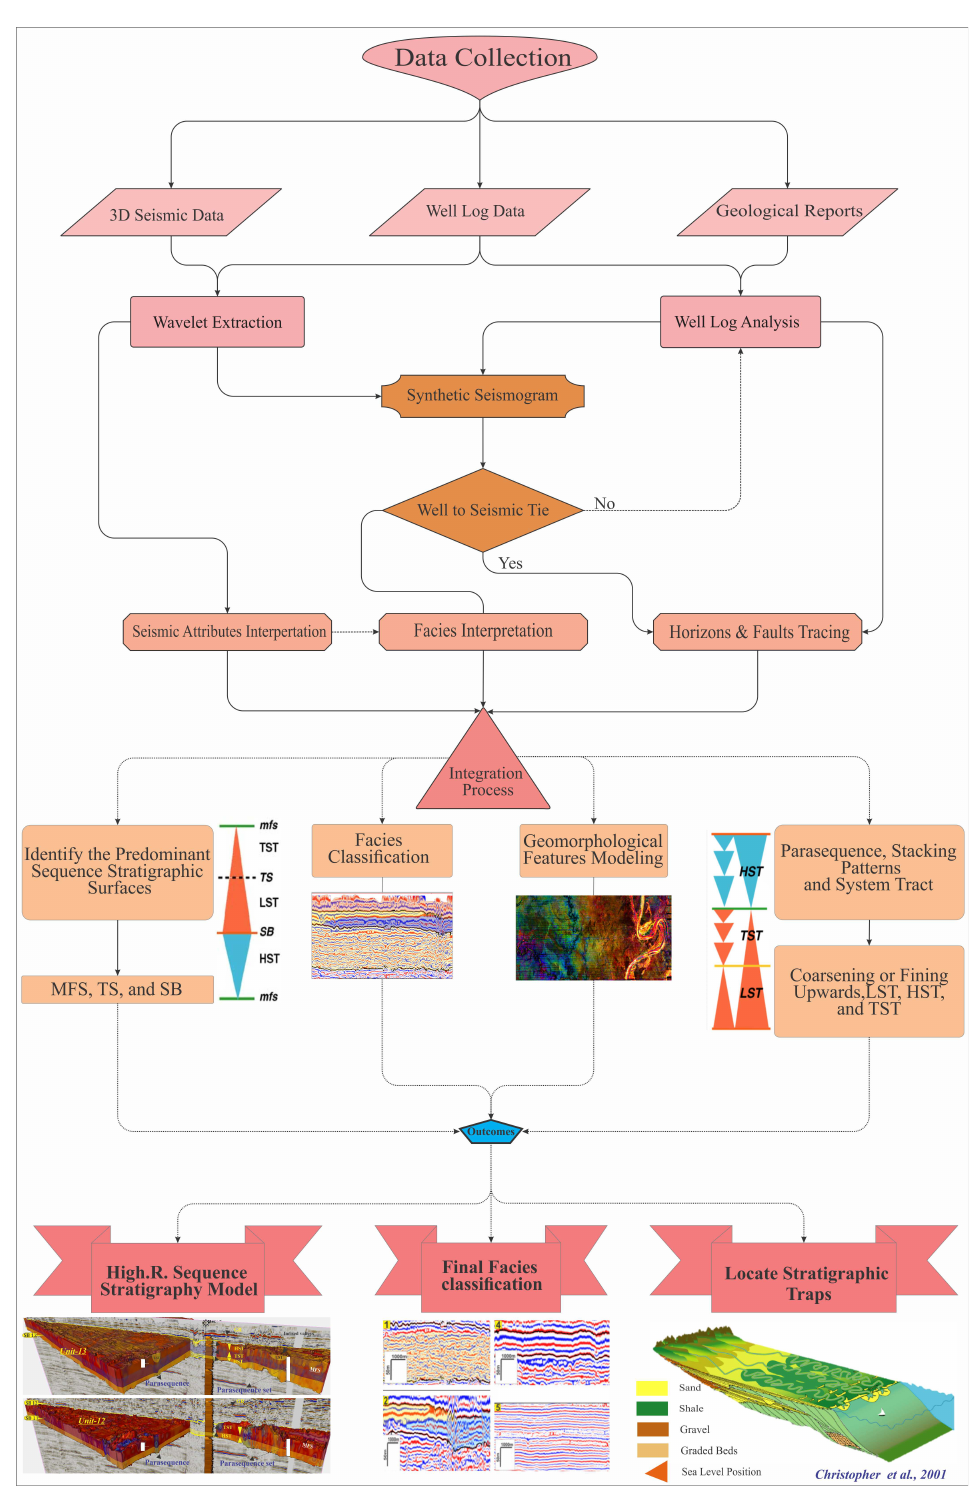
Figure 4. The general workflow for this